Question: Describe this figure in one sentence.
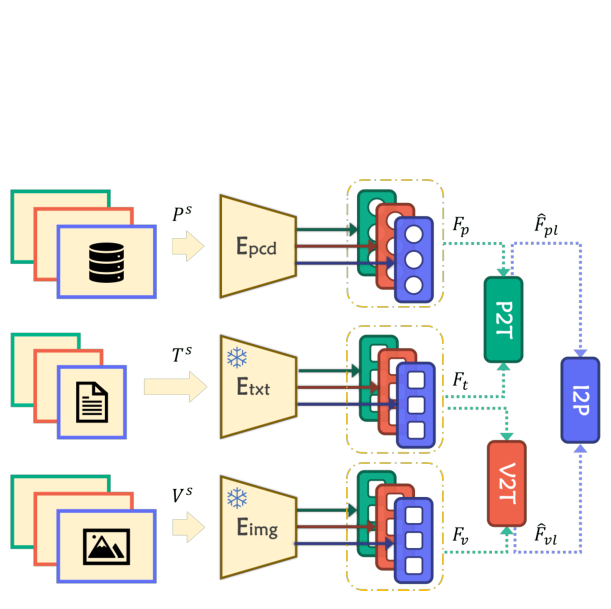
Answer: Label-space alignment in M3Net. We leverage image features Fv, point cloud features Fp, and text embedding Ft ex- tracted from Eimg, Epcd, and Etxt, respectively, for regularization via the I2P, P2T, and V2T losses in the label-space alignment.